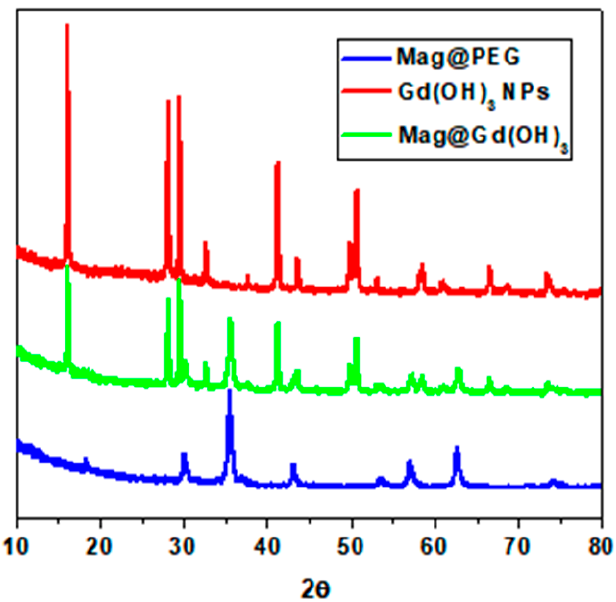
Figure 1. Comparative XRD diffractograms of the raw and hybrid nanoparticles.